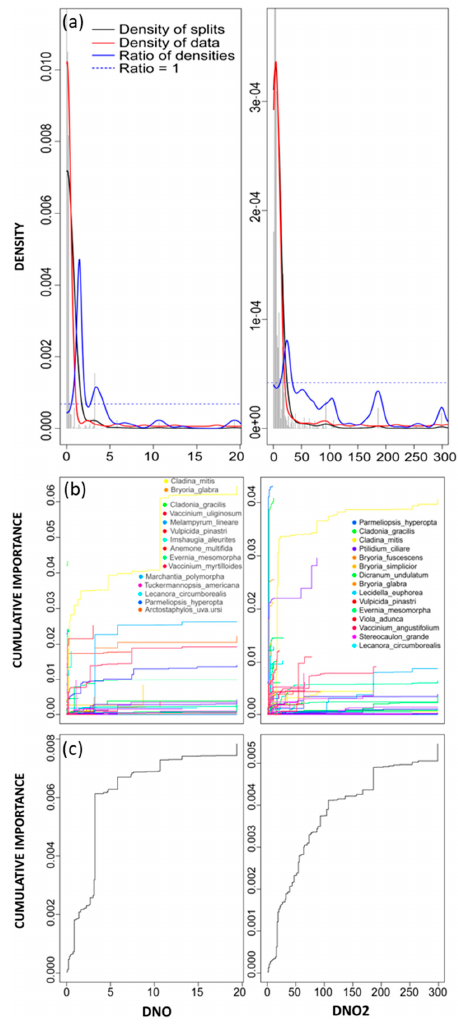
Figure 6. Gradient forest results for DNO (left column) and DNO 2 (right column). ( a ) Densities plot with binned split importance values (grey histogram bars), the density of data (red line), the density of splits (black line), the ratio of split-over-density (blue line). The dashed line is where the ratio = 1. Relatively greater community level changes (high split importance values) occur when the ratio of densities > 1; ( b ) species cumulative importance plot showing the cumulative distribution of splits importance scaled by R 2 . Each line represents an individual species, and the legend identifies the top 15 species experiencing the largest composition changes across the gradient; and ( c ) community cumulative importance plots calculated by the sum of weighted averages of all species in ( b ) and showing the overall pattern of compositional change for all